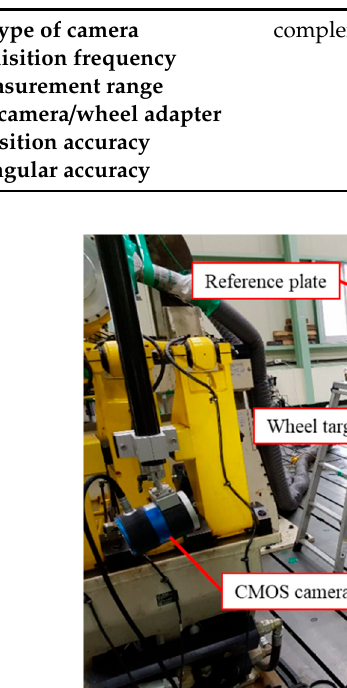
Table 2. Specifications of camera system.